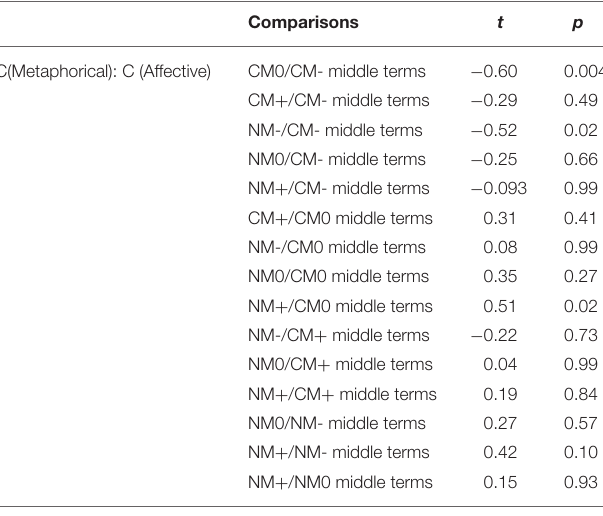
TABLE 9 | t/p -values for accuracy, comparing middle term conditions (Experiment 2).